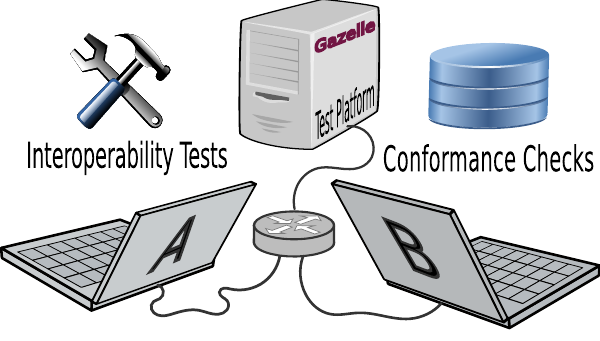
Figure 4. Testing interoperability and validating the conformance with Integration